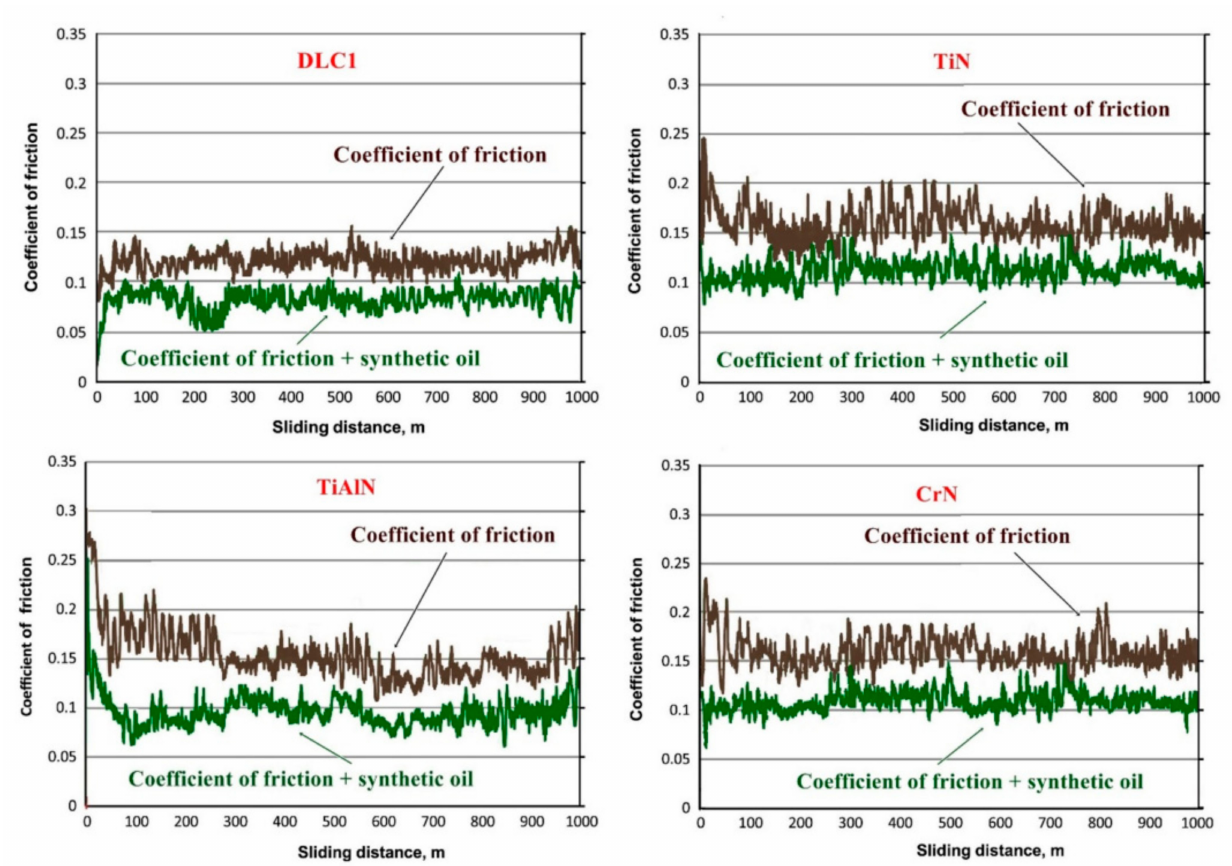
Figure 5. Coefficients of friction and wear recorded in dry friction conditions for the 100Cr6 steel ball system: DLC1 coating, TiN coating, TiAlN coating and CrN